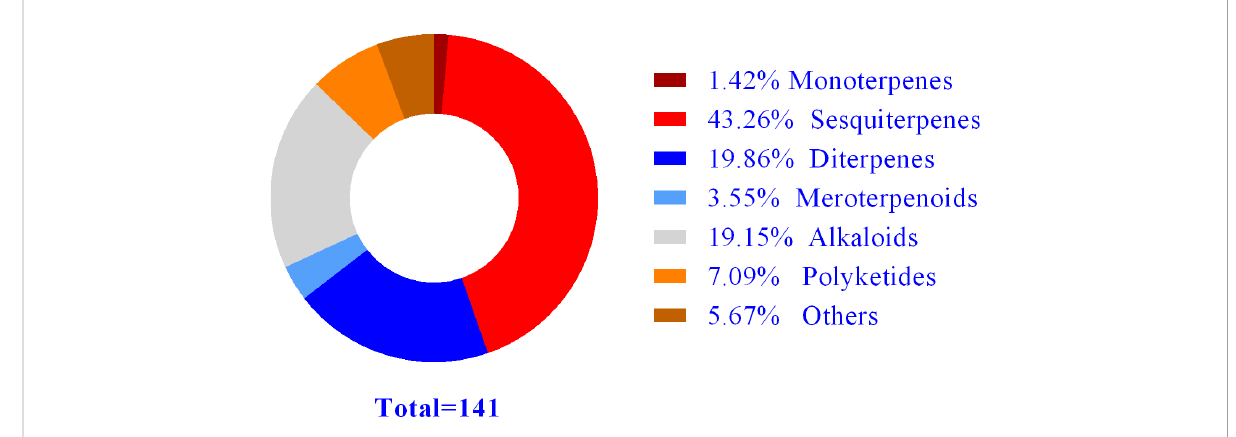
FIGURE 1 The distribution of total new metabolites in Eutypella fungi.